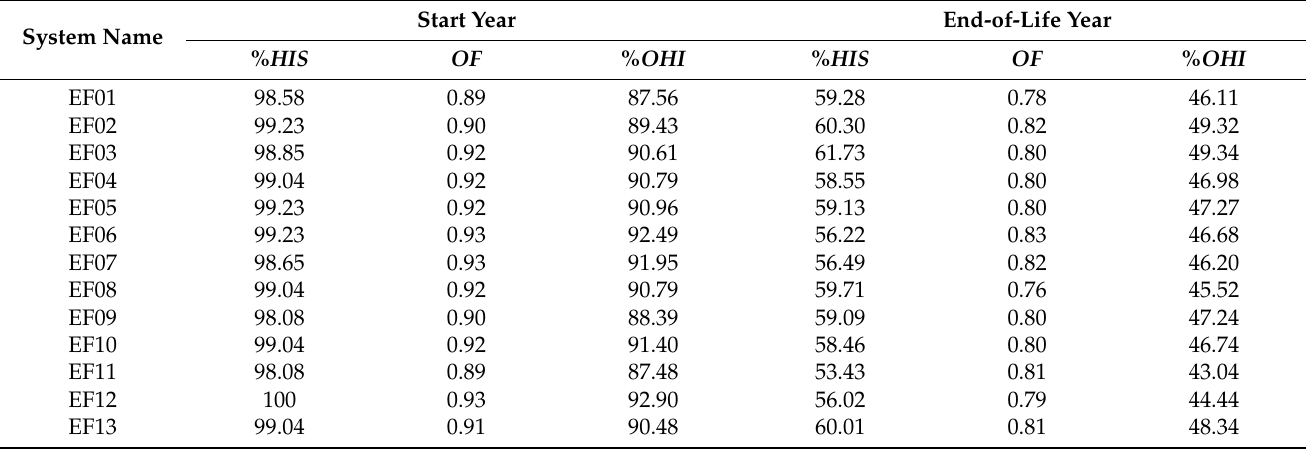
Table 5. % OHI calculation of 13 sample of the retired underground cable